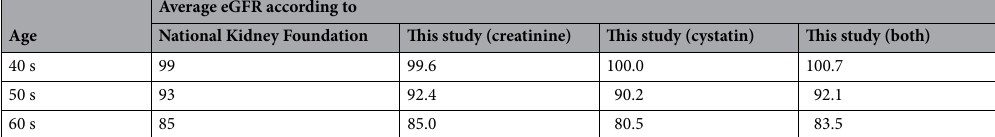
Table 3. eGFR values by age. This shows average eGFR values by decade of life for the general population (provided by National Kidney Foundation) and for the three eGFR formulae used in this